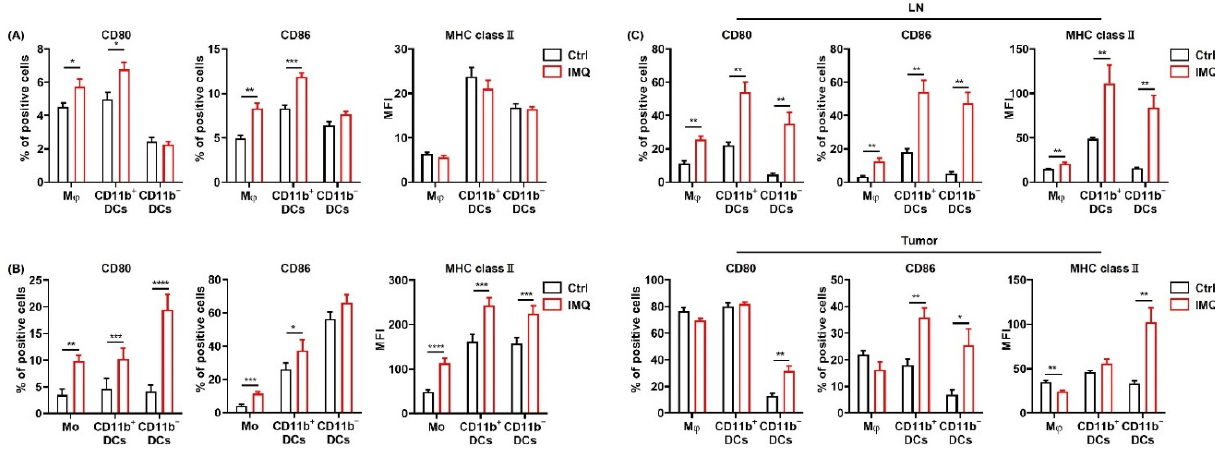
Figure 2. IMQ activates myeloid cells, leading to the upregulation of costimulatory molecules and MHC class II. ( A ) Flow cytometric analysis of CD80, CD86, and MHC class II expression in myeloid cells of the murine spleen ( A ) and human blood ( B ) stimulated with IMQ for 24 h (n = 8 ( A ) and n = 18 ( B ) in each group, respectively). ( C ) Flow cytometric analysis of CD80, CD86, and MHC class II expression of myeloid cells in the lymph nodes and tumors 5 days after tumor inoculation with topical IMQ application at day 4 ( n = 6 in each group). Ctrl: control, IMQ: imiquimod, M φ : macrophages, Mo: monocytes, DCs: dendritic cells, LNs: lymph nodes. Error bars indicate ±1 SEM; * p < 0.05, ** p < 0.01, *** p < 0.001, **** p < 0.0001.